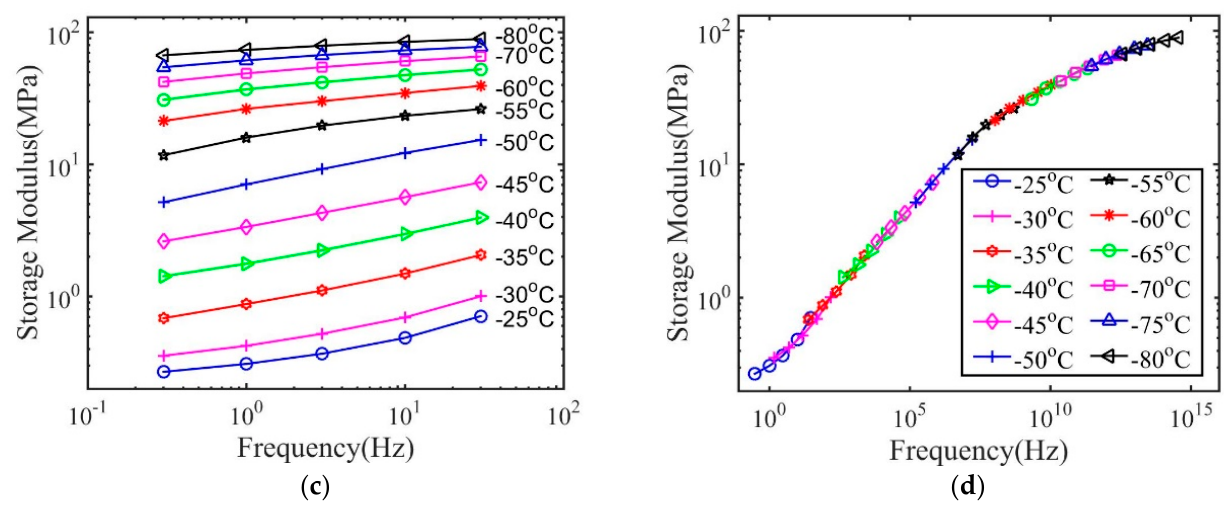
Figure 6. The storage modulus for polymers with 2 wt.% crosslink density and treatment by IPA for ( a ) 1 h and ( c ) 10 h, and the master curve for ( b ) 1 h and ( d ) 10 h.